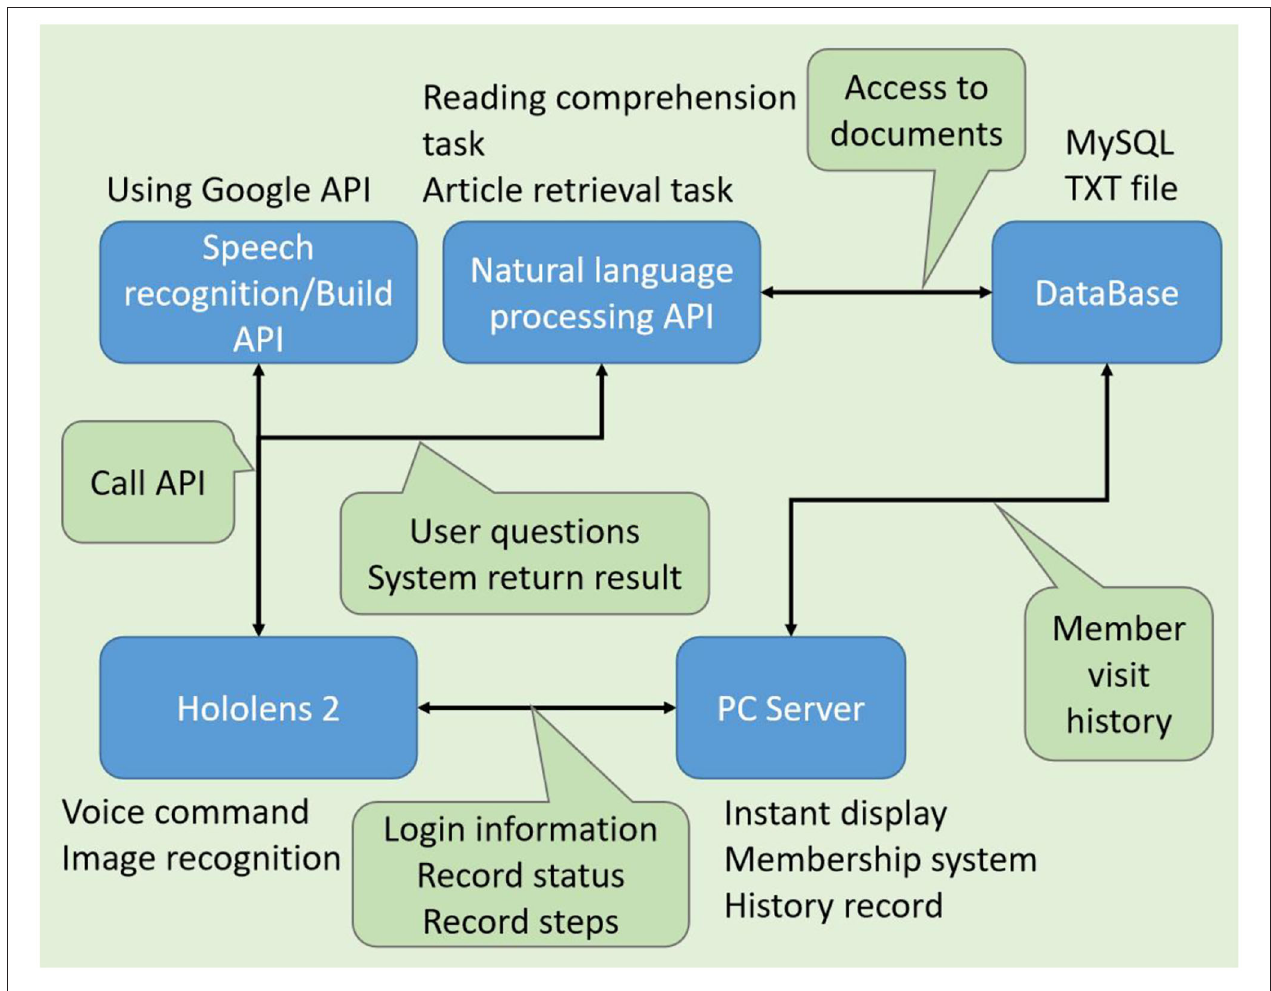
FIGURE 15 | Software architecture